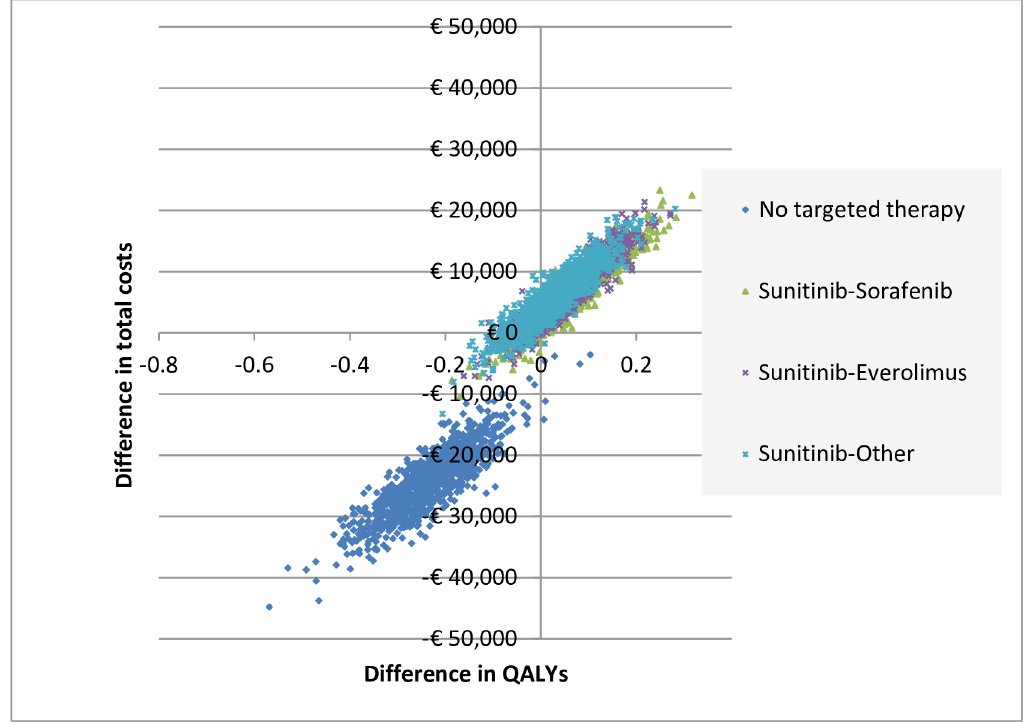
Fig 3. Cost-effectivenessplane for various treatment scenarios versus real-world treatment